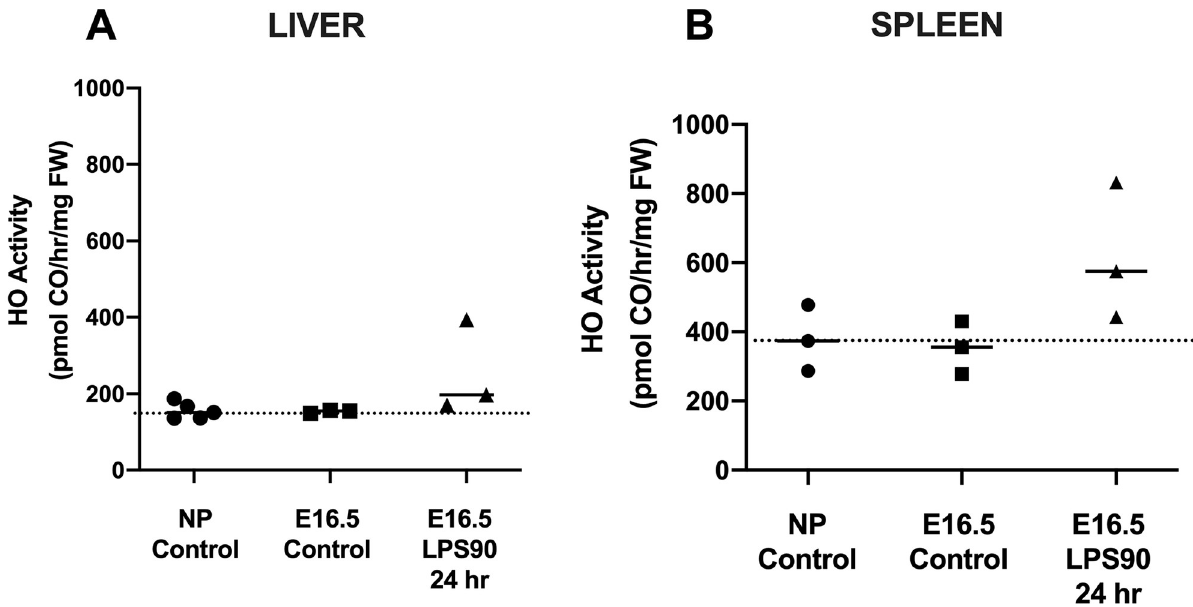
Fig 3. HO activity in liver and spleen of non-pregnant (NP) adult females and pregnant (P) dams following LPS at a dose of 90 ug/kg (LPS90). LPS was administered i.p. to pregnant Wt dams at E15.5 (Non-pregnant Control, n = 5; Control (vehicle), n = 3; LPS90, n = 3) and HO activity was measured 24 hrs later. Controls were matched by chronologic age, GA, and genotype. ( A ) Liver and ( B ) Spleen HO activity in NP females, pregnant control dams and LPS-treated dams were similar. FW: fresh weight. No statistical differences were found between any of the groups. https://doi.org/10.1371/journal.pone.0252642.g003 increased (511 ± 76 pmol/hr/mg FW, n = 3 [each pooled from 3 fetuses]) compared with con- trol fetuses (341 ± 60 pmol/hr/mg FW, n = 3 [each pooled from 3 fetuses], p = 0.04) (Fig 4B). Fetal brains did not show significant increases in HO activity (78 ± 7 pmol/hr/mg FW, n = 3 [each pooled from 3 fetuses]) compared with GA-matched fetal controls (66 ± 10 pmol/hr/mg FW, n = 3 [each pooled from 3 fetuses]) (Fig 4C).